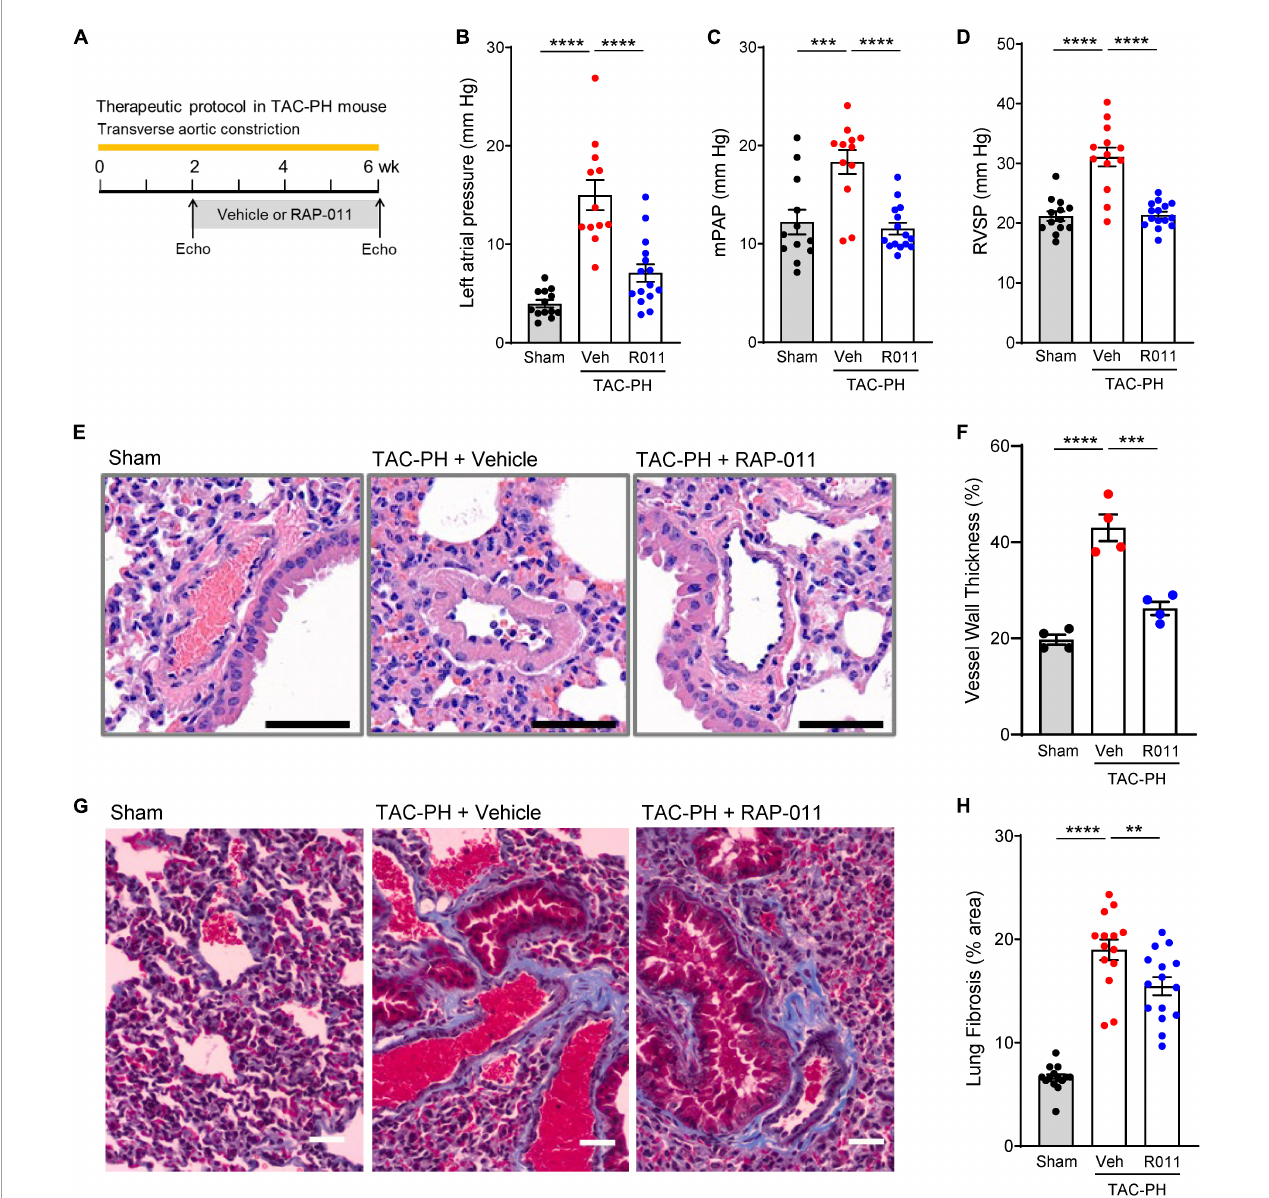
FIGURE2 ActRIIA-Fc improves pulmonary vascular remodeling and reduces PH in a TAC-PH mouse model. (A) Experimental approach used to assess effects of ActRIIA-Fc (RAP-011). Wild-type mice were subjected to TAC and treated twice weekly with RAP-011 (R011, 10 mg/kg, s.c.) or vehicle (veh, PBS) for 4 weeks starting 2 weeks post-surgery to promote development of PH in the untreated state. (B) Left atrial pressure, (C) mean pulmonary arterial pressure (mPAP), and (D) RV systolic pressure (RVSP). (E) Images of representative lung sections stained with hematoxylin and eosin showing degree of vascular remodeling. Scale bar, 50 µ m. (F) Quantification of vessel wall thickness as a percentage of vessel outer diameter. (G) Images of lung sections stained with Masson’s trichrome to detect fibrosis. Scale bar, 50 µ m. (H) Quantification of fibrotic tissue area. Data are means ± SEM. Analysis by one-way ANOVA and Dunnett’s post-hoc test (** P < 0.01, *** P < 0.001, **** P <